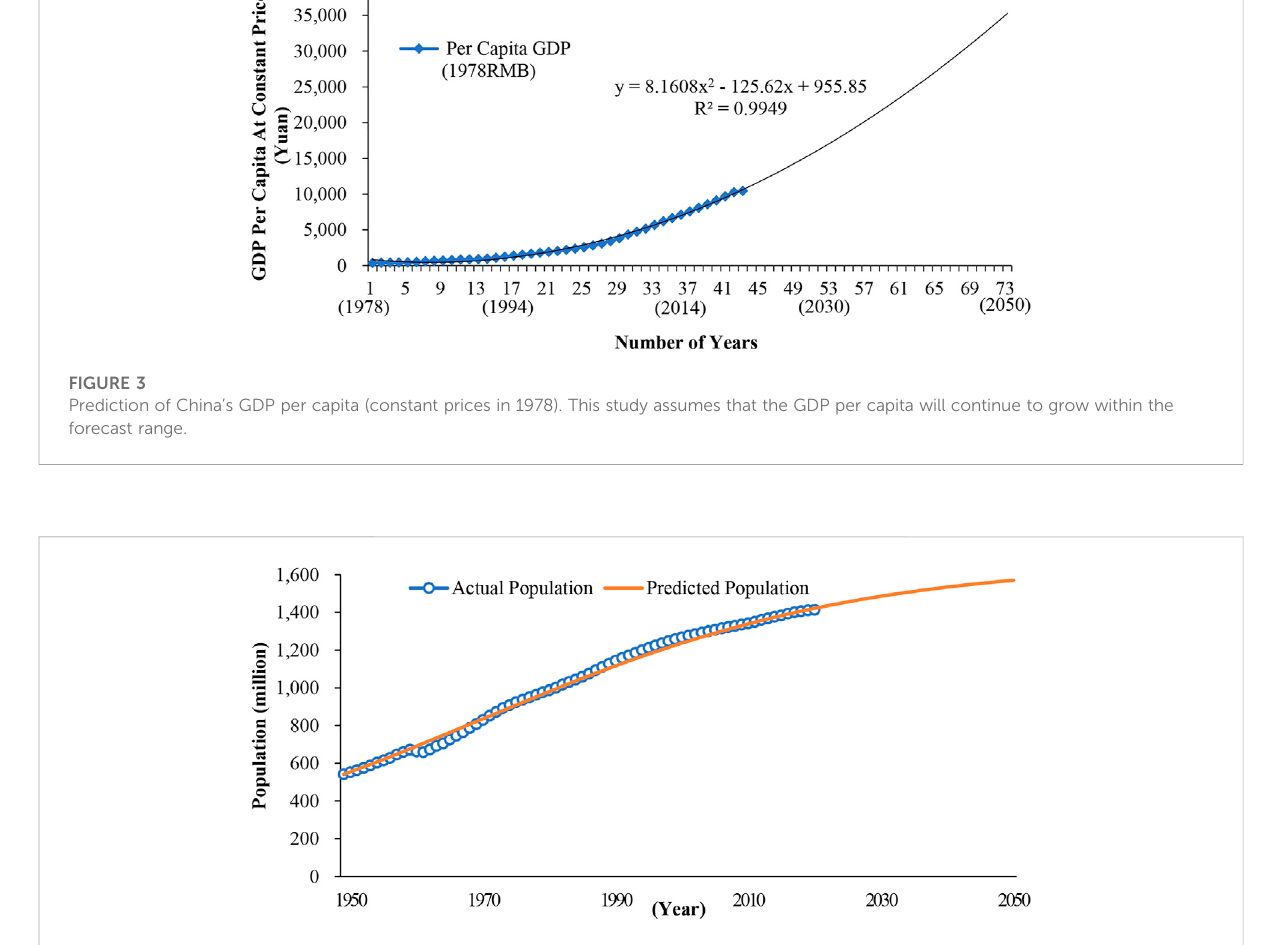
FIGURE 4 Population trends in China. This study will predict that China ’ s population will continue to